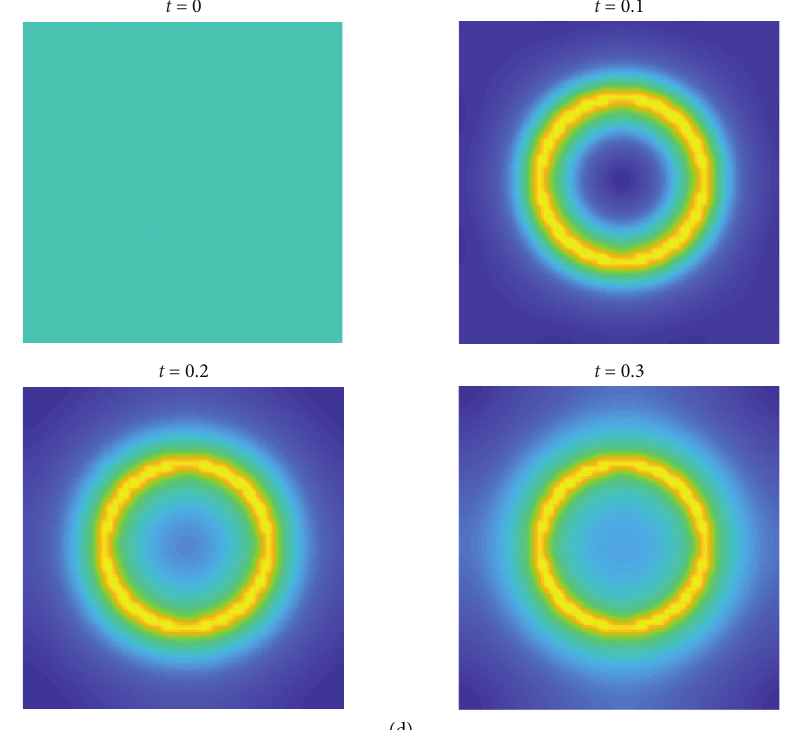
Figure 14: Numerical solution and Turing pattern of Experiment 2 with initial condition u ( x,y, 0 ) � cos ( π ( x 2 + y 2 )) and v ( x,y, 0 ) �